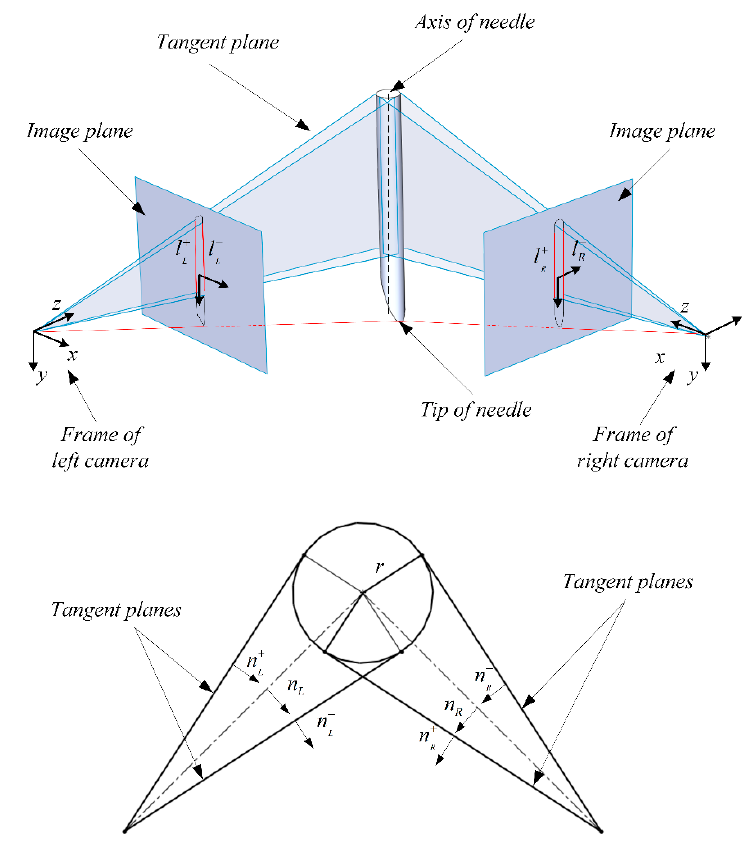
Figure 7. Imaging Figure 7. Imaging model.